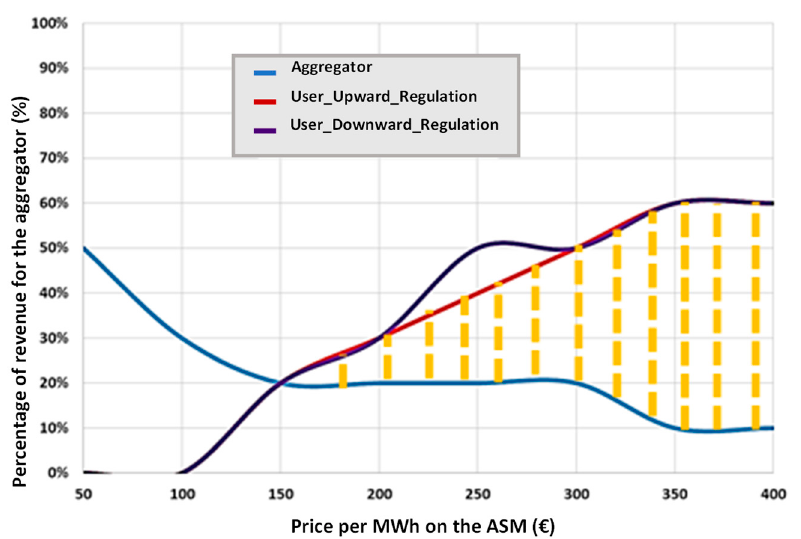
Figure 17. Aggregator-users profit area for 4500 MWh of energy exchanged (EMP costs = 0 and COM costs = 0).